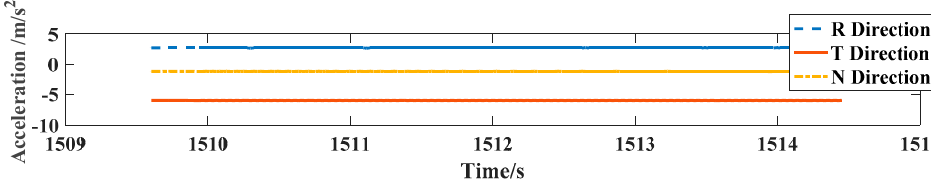
Figure 5. Maneuvering accelerations of RS in RTN orbit coordinate system.